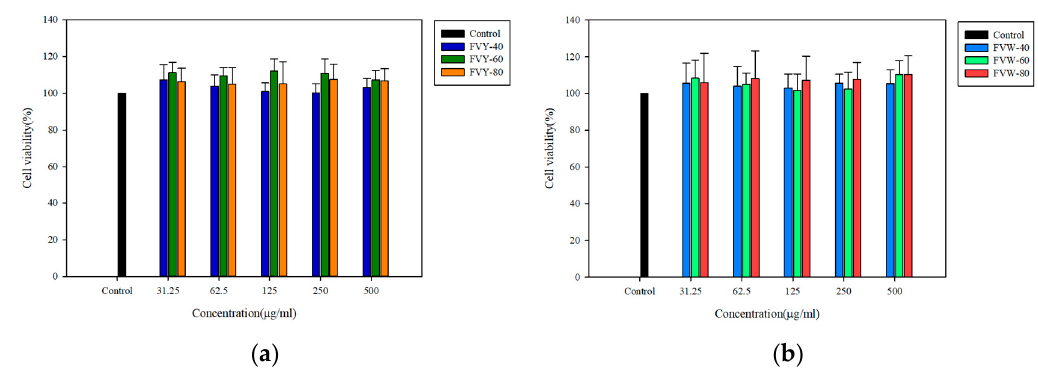
Figure 7. Cell viability was analyzed by 3-(4,5-dimethylthiazolyl-2)2,5 diphenyltetrazolium bromide (MTT) assay. L929 were treated with ( a ) FVYs and ( b ) FVWs for 24 h. Data were expressed as a mean ± standard deviations. ( n = 4). ( p < 0.05).